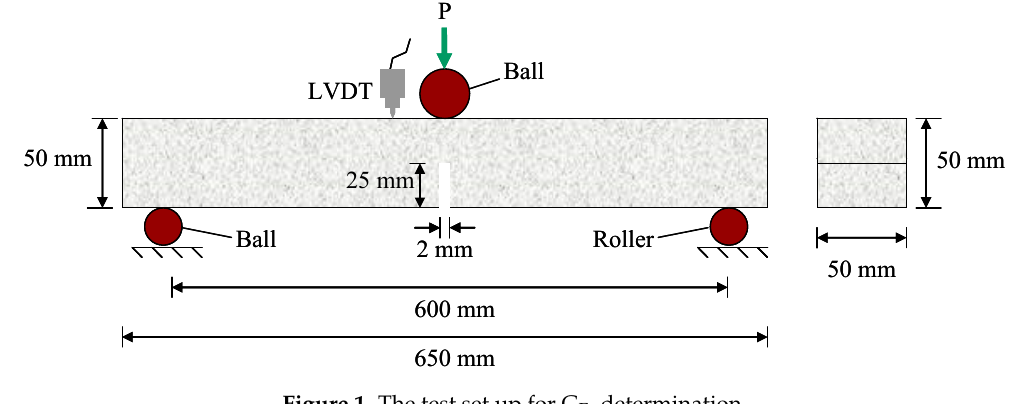
Figure 1. The test set up for G F –determination.